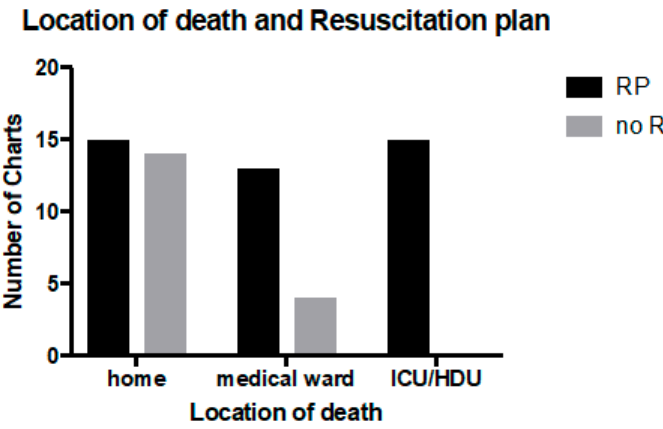
Figure 2. Location of death and presence of a resuscitation plan in 61 patients. ICU: intensive care unit; HDU: high dependency unit.